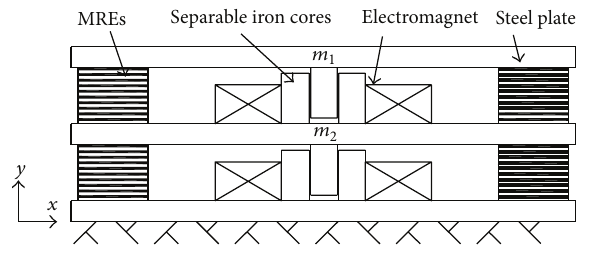
Figure 1: Schematic diagram of MRE isolation